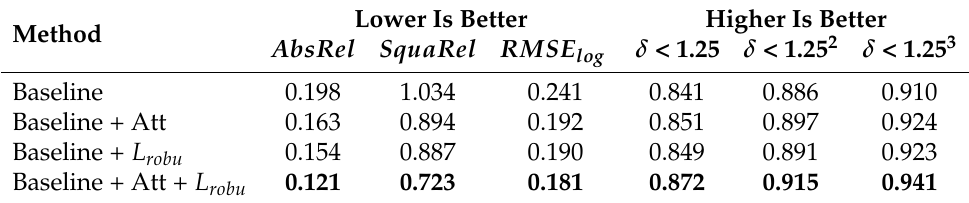
Table 4. Evaluation results on CCP